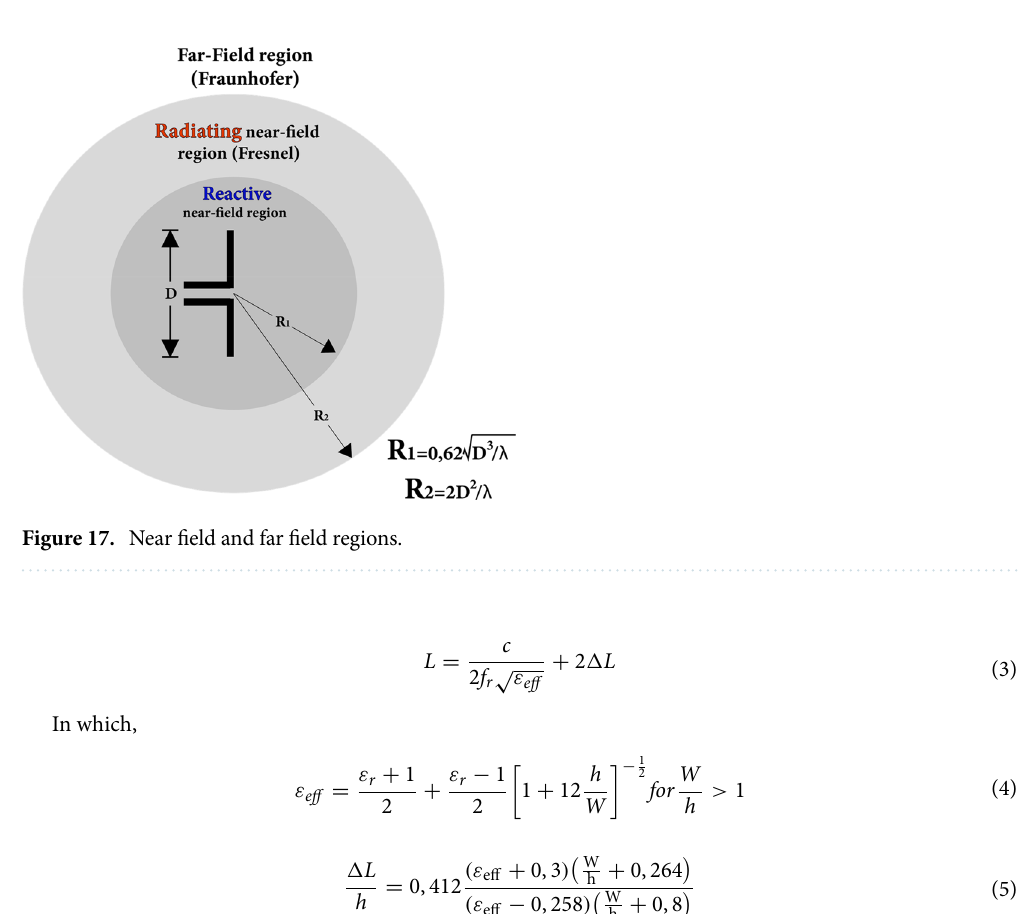
Figure 16. Connection between the coaxial cable and the Yagi-Uda antenna analyzed.